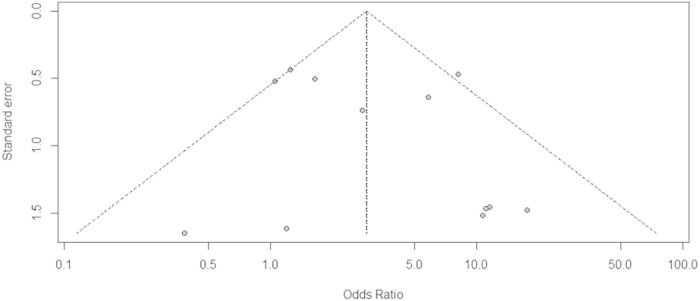
The Begg’s funnel plot for assessment of publication bias in the meta-analysis (each study is represented by a point).